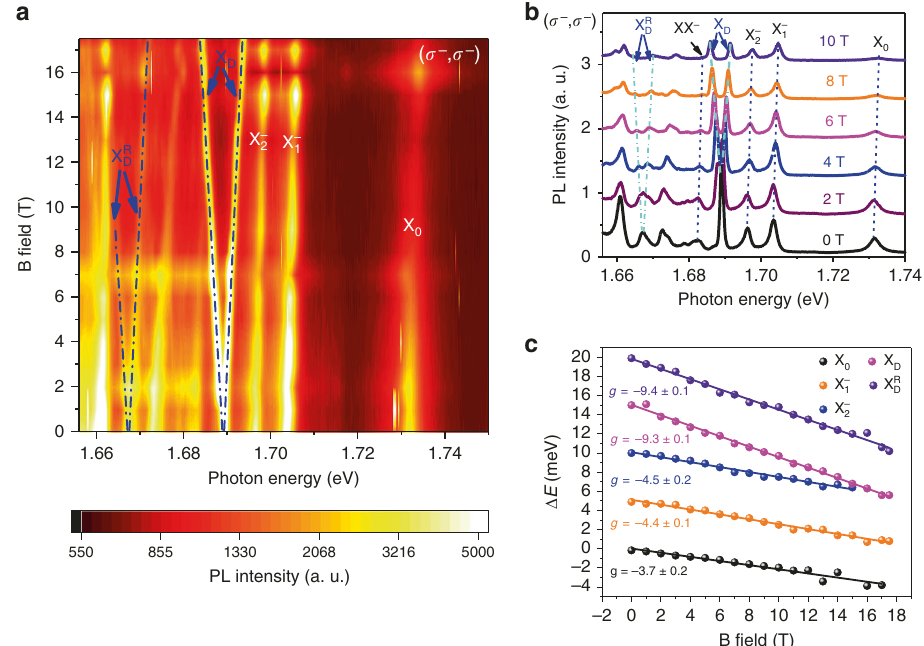
Fig. 2 Valley-resolved magneto-PL spectra of the dark-exciton and its replica. a Valley-resolved PL spectra at 4.2 K as a function of the emission photon energy and the applied out-of-plane magnetic fi eld, with the excitation of a CW laser centered at 1.879 eV and excitation power of 60 µ W. The color represents the PL intensity. The dark exciton and its replica exhibit distinctively different magnetic fi eld dependence compared to bright excitonic complexes. b Line traces of the PL spectra as a function of the applied magnetic fi eld. The dashed lines are the guide for the eye. c g -factor for different excitonic complexes obtained from the Zeeman splitting between the E K and E K ′ , obtained from ( a ) and Supplementary Fig. 5c. The data sets are